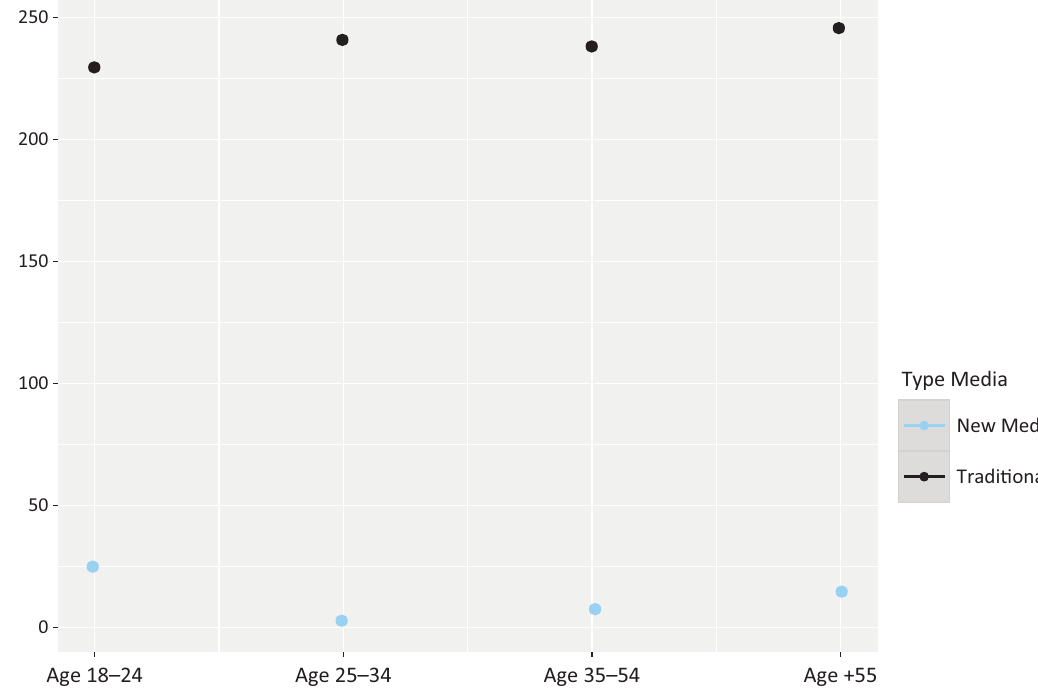
Figure 2. Mean of betweenness centrality scores in the audience networks by different age